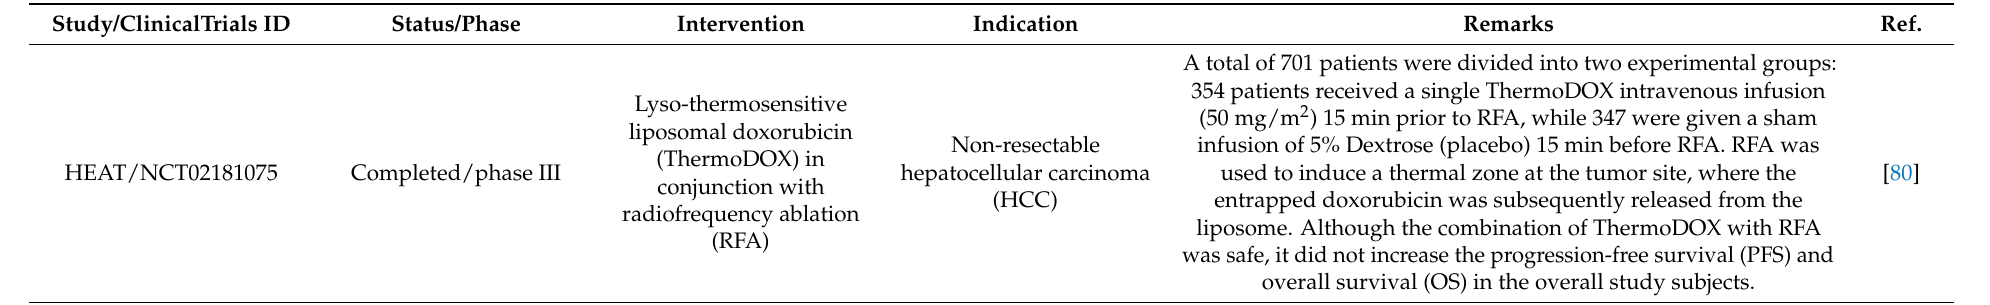
Table 3. Summary of ThermoDOX clinical